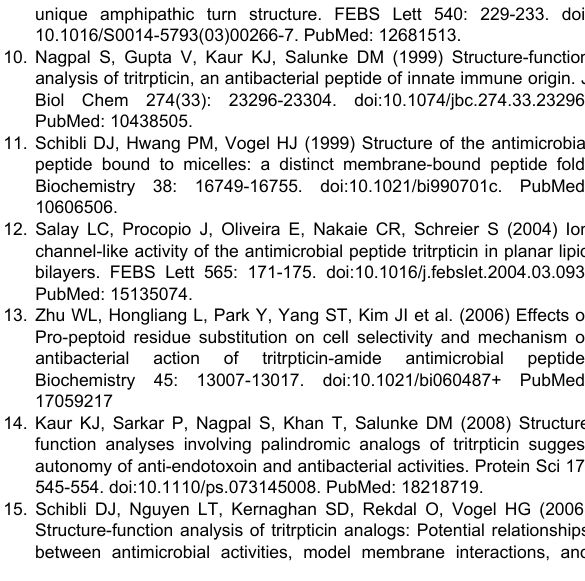
sepharose elution profile. C. SDS-PAGE profile of purification. LMW refers to Low molecular weight marker. (TIF) Figure S2. ELISA based binding of clone 6C6 (A) and 2A6 (B) to tritripticin. Both the clones were not able to bind indolicidin and BSA (used as negative control). (TIF) Figure S3. Comparison of antimicrobial activity of tritripticin and phage displayed random peptide picked by mAb 6C6D7 against different bacterial strains. An unrelated peptide EHGTPPRVMSSM was also used as negative control and as expected did not led to the formation of clearance zone (not shown in the figure). 50 nmoles of peptides were used for assay. (TIF) Figure S4. RMSDs of Cα atoms of the CDRs (black) and that of whole 6C6D7 Fv (red) during the 8 ns MD simulation. The averaged structure from last 4 ns run was energy minimized and used for docking studies.